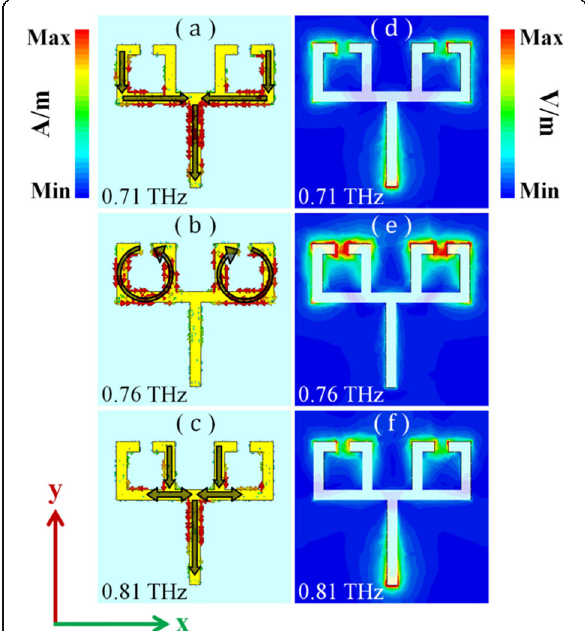
Fig. 5 Surface current at different frequencies: a EIT peak frequency, b transmission dip with lower frequency, c transmission dip with higher frequency. Electric field distribution at different frequencies: d EIT peak frequency, e electric field distribution at the transmission dip with lower frequency. f Electric field distribution at the transmission dip with higher